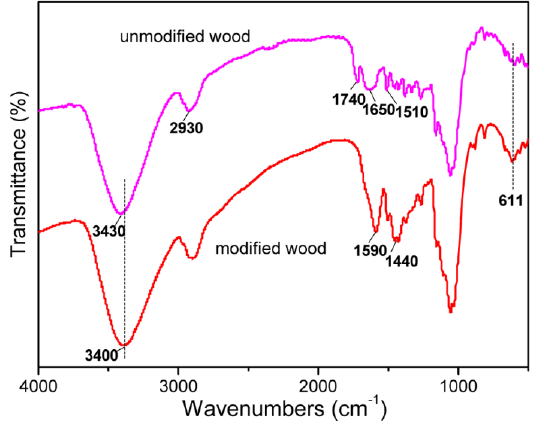
Figure 3. Fourier transform infrared (FTIR) spectroscopy of unmodified wood and MW–18 wt